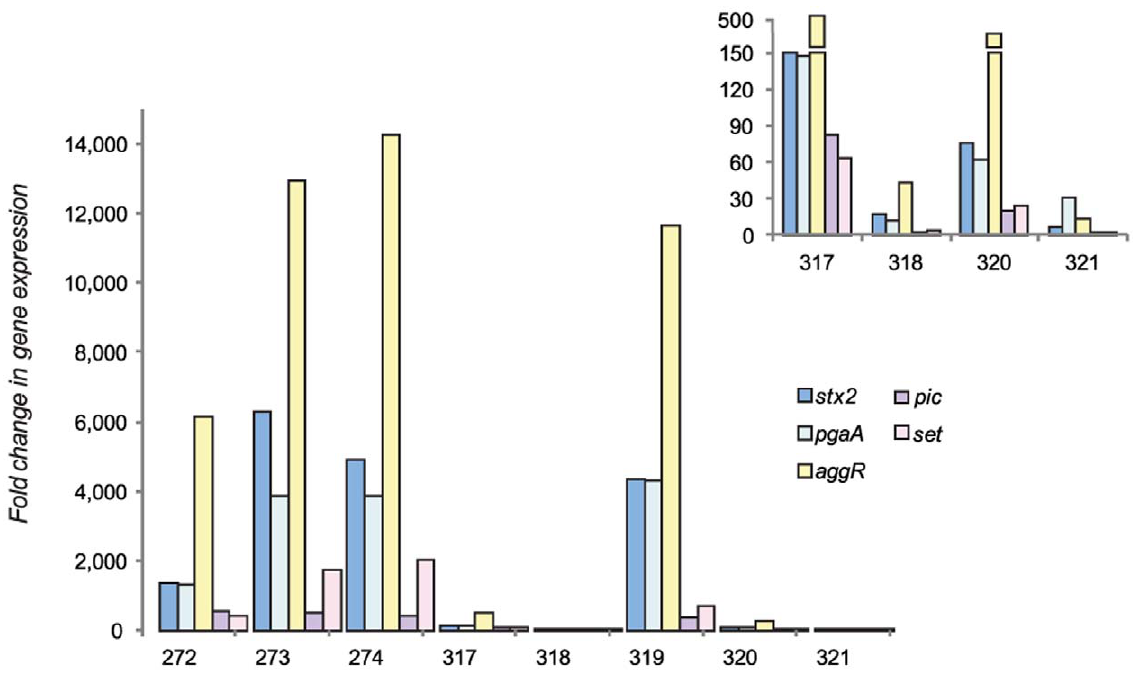
Figure 3. Variation in bacterial gene expression among mice challenged with E.coli O104:H4 for 13–15 days. Y-axis represents the fold change in cecal gene expression levels among eight mice infected with E. coli O104:H4 at 13–15 days post infection relative to mice infected for seven days. The inset highlights the four mice with fold change values that cannot be visualized using the y-axis in the larger histogram. Broken bars indicate a large change in the y-axis value, while the x-axis refers to the mouse identification number. doi:10.1371/journal.pone.0041628.g003 were not noted for mice infected with E. coli O157:H7, which colonized in single layers displaying the characteristic pattern of intimate attachment to the epithelia [15,16] via genes encoded on the locus of enterocyte effacement (LEE) [17]. The E. coli